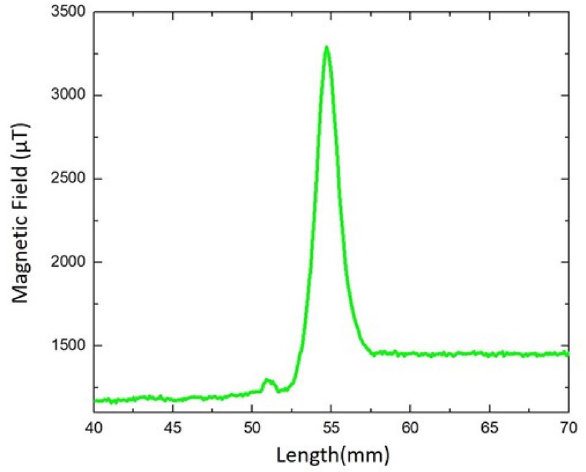
Fig. 17 Experimental result of magnetic field Y of a rectangular defect B1 with ordered magnetic domains